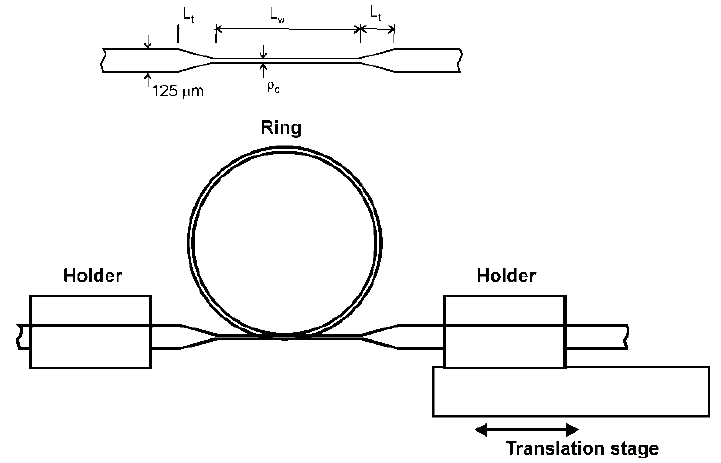
Figure 1. Sketch of the single-loop fiber optic displacement